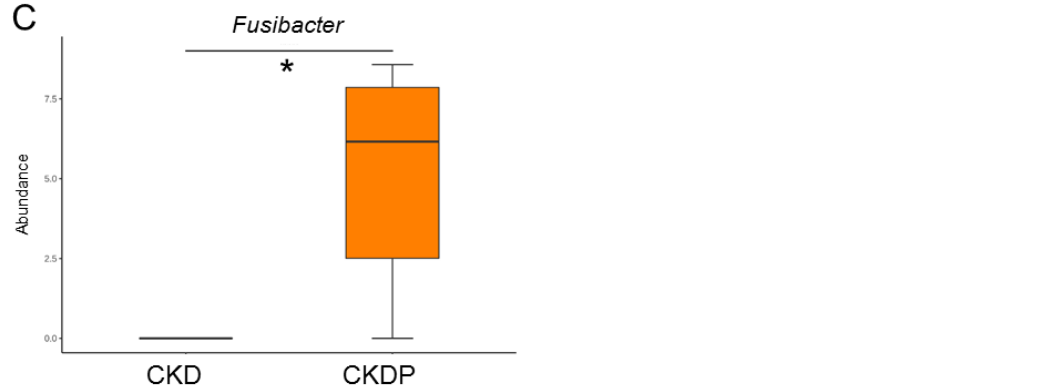
Figure 8. Effect of perinatal propionate supplementation on the gut microbiota in 12-week-old male offspring. Genus-level relative abundance of ( A ) Fournierella , ( B ) Negativibacillus , and ( C ) Fusibacter . * p < 0.05.